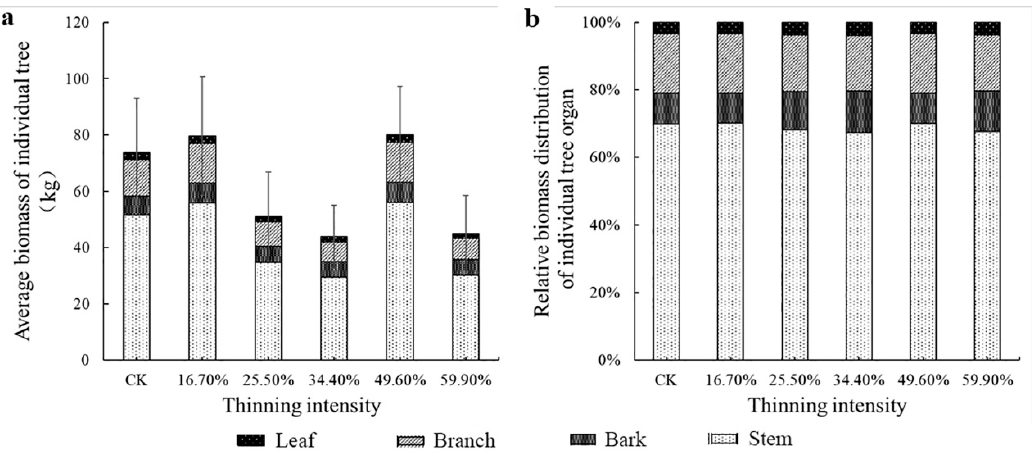
Figure 4. The average individual tree organ biomass and its allocation of larch. Note: ( a) is larch average biomass of individual tree, ( b ) is larch relative biomass distribution of individual tree organ.